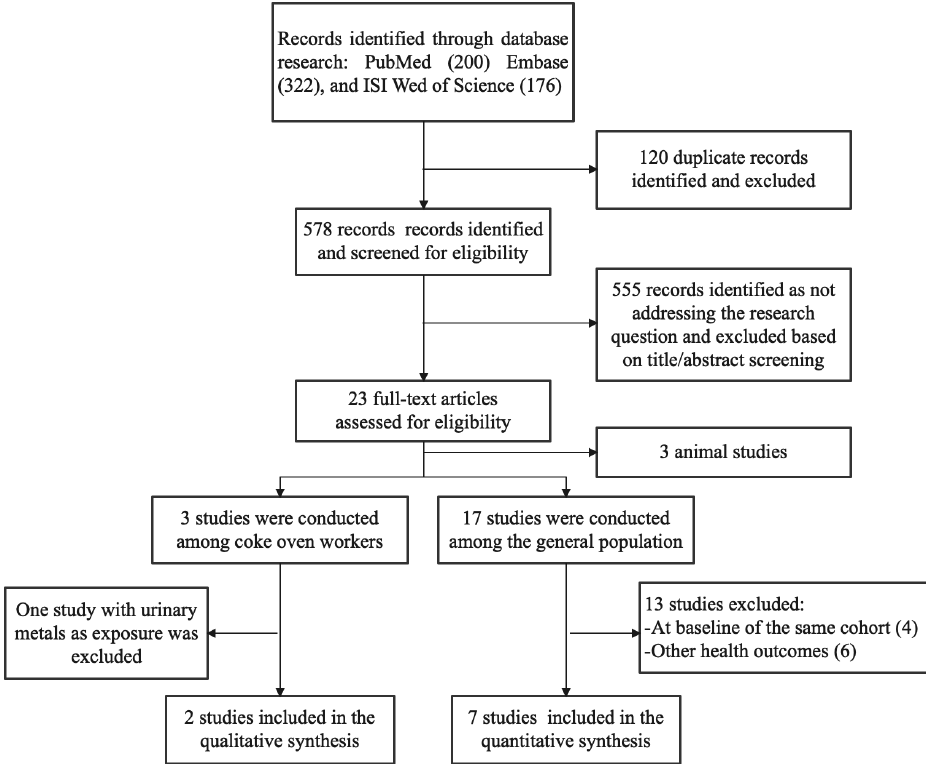
Figure 1. Results of systematic literature